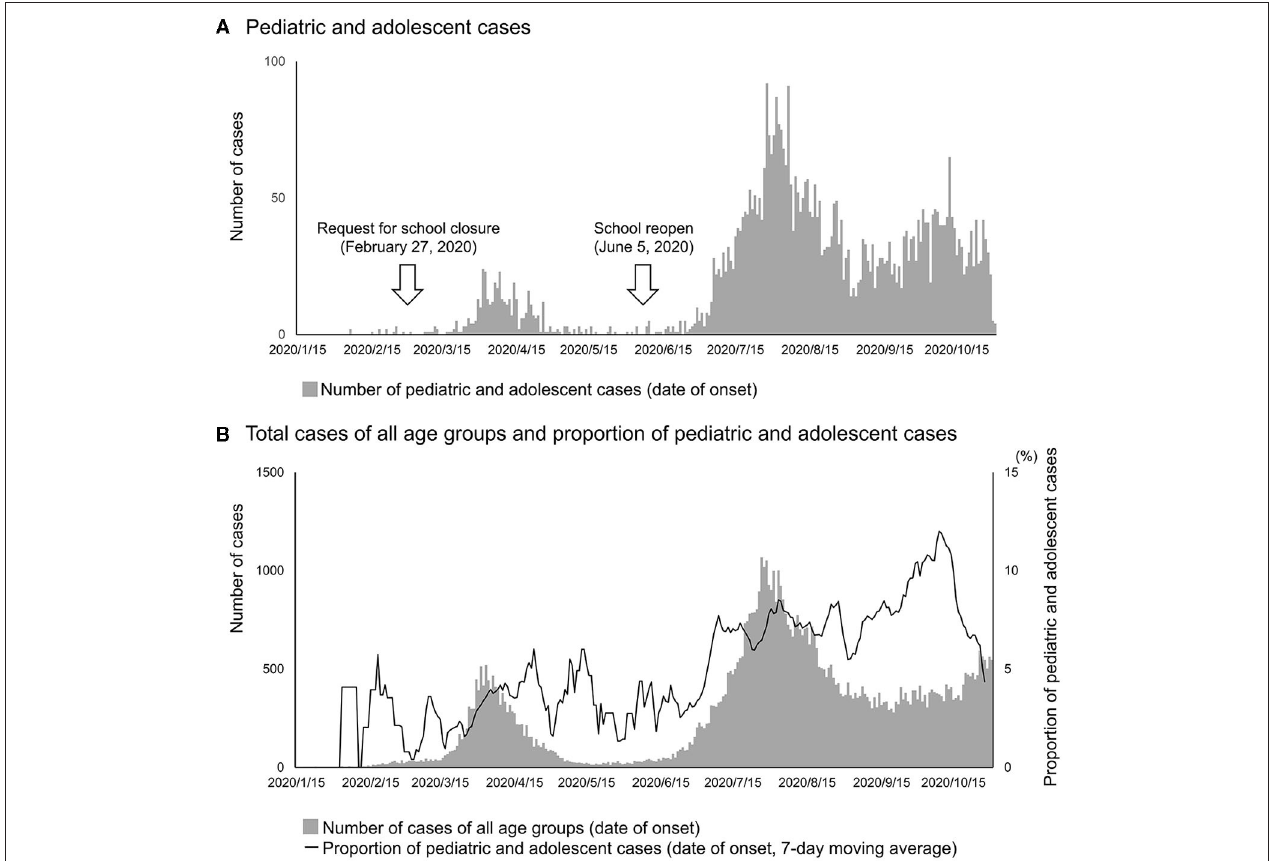
FIGURE 1 | Temporal distribution of pediatric and adolescent cases with COVID-19 in Japan, from January 15 to October 31, 2020. The numbers of COVID-19 cases were plotted for (A) pediatric and adolescent cases and (B) total cases of all age groups based on date of onset. The date of onset was available for 5,037 out of 7,758 pediatric and adolescent cases, and 75,622 out of 100,436 cases of all age groups. A 7-day moving average (values of 3 days before and 3 days after the indicated date) of the proportion of pediatric cases out of the total cases was also plotted in (B)